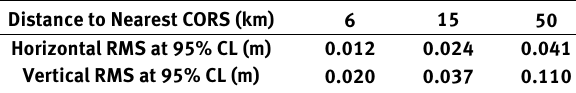
Table 2. Precisions for NRTK solutions (2-minute observation win- dows) for a range of NRTK cell sizes (Janssen and Haasdyk 2011).